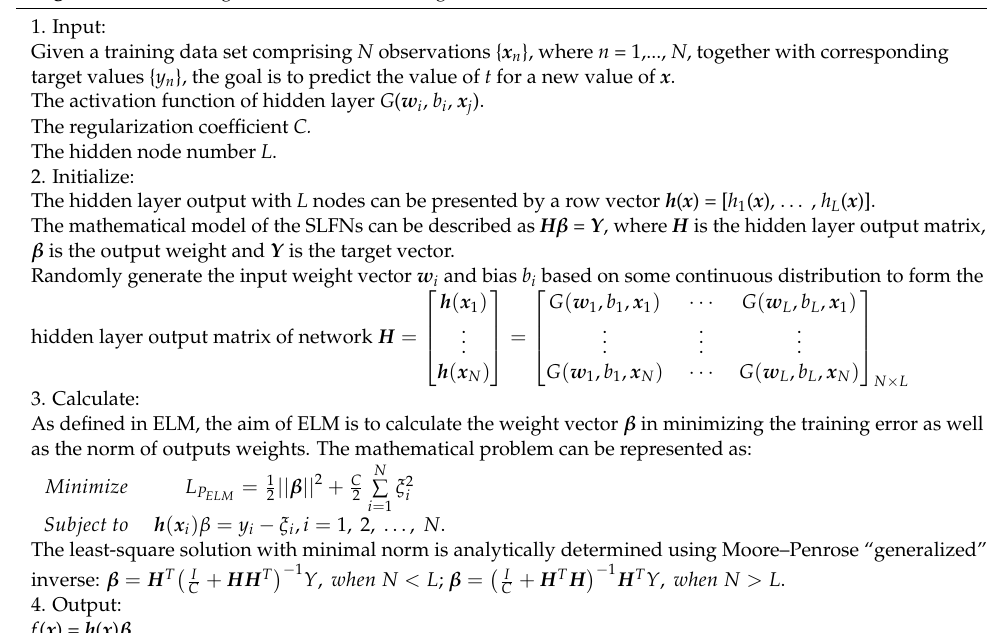
Algorithm 1: Learning Routine of ELM for